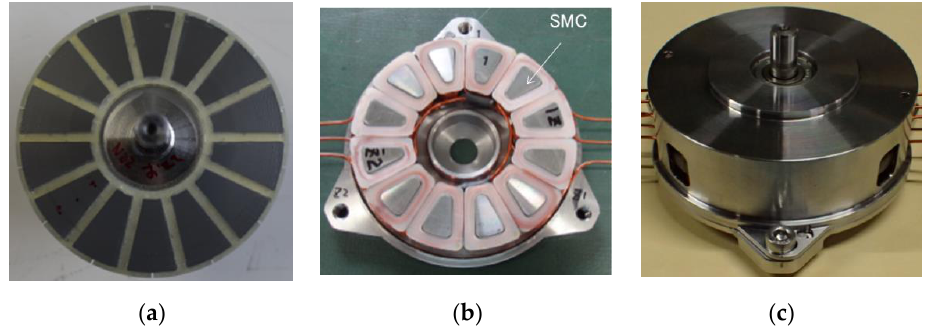
Figure 18. Prototype motor: ( a ) rotor; ( b ) stator; ( c ) overall view. Table 5. Specifications of prototype axial-gap motor.